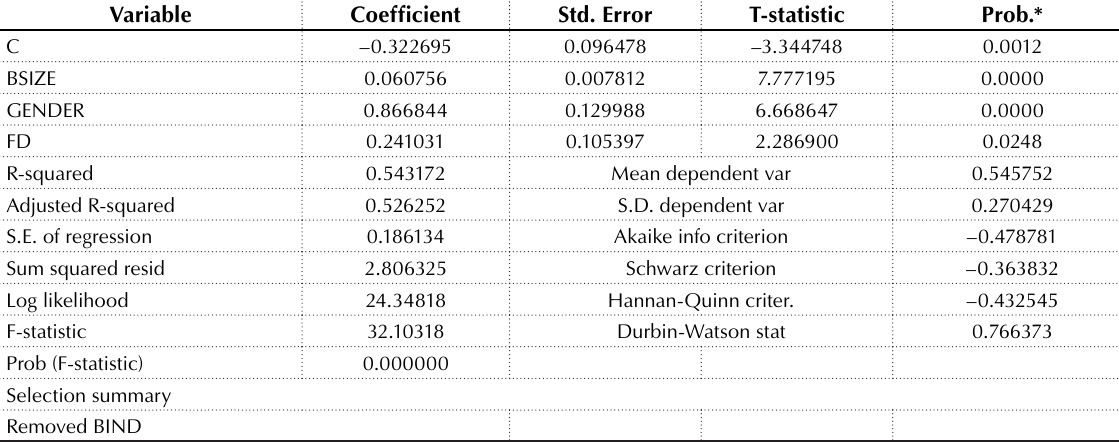
Table 2. Stepwise